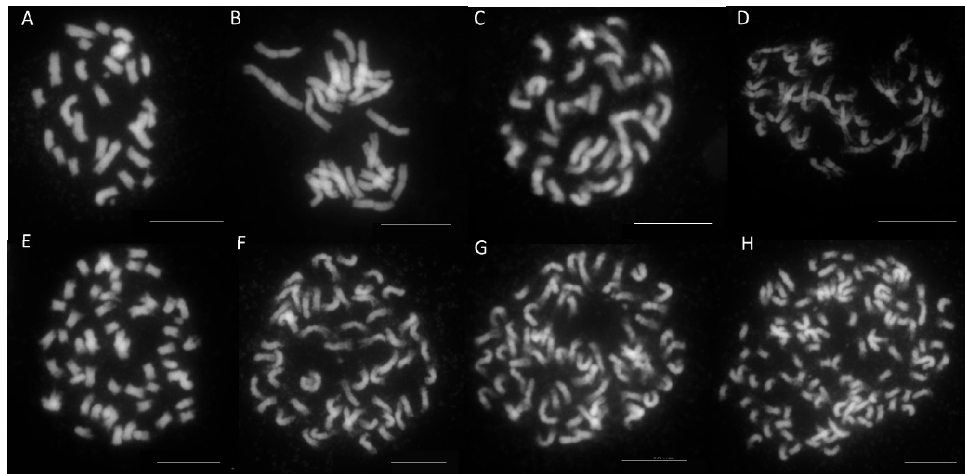
Figure 3. Chromosome counts of Geranium genotypes: ( A ) G. phaeum ‘Angelina’—3.52 pg/2C and 2n = 28; ( B ) G. wallichianum ‘Sylvia’s surprise’—6.78 pg/2C and 2n = 38; ( C ) G. × riversleaianum ‘Mavis Simpson’—4.31 pg/2C and 2n = 38; ( D ) G. ‘Azure Rush’—8.90 pg/2C and 2n = 42; ( E ) G. ‘Catherine Deneuve’—6.95 pg/2C and 2n = 54; ( F ) G. himalayense ‘Derrick Cook’—7.49 pg/2C and 2n = 56; ( G ) G. sanguineum ‘Blushing Turtle’—7.80 pg/2C and 2n = 66; ( H ) G. ‘Tiny Monster’—12.94 pg/2C and 2n = 108/110 (bar = 10 μ m).